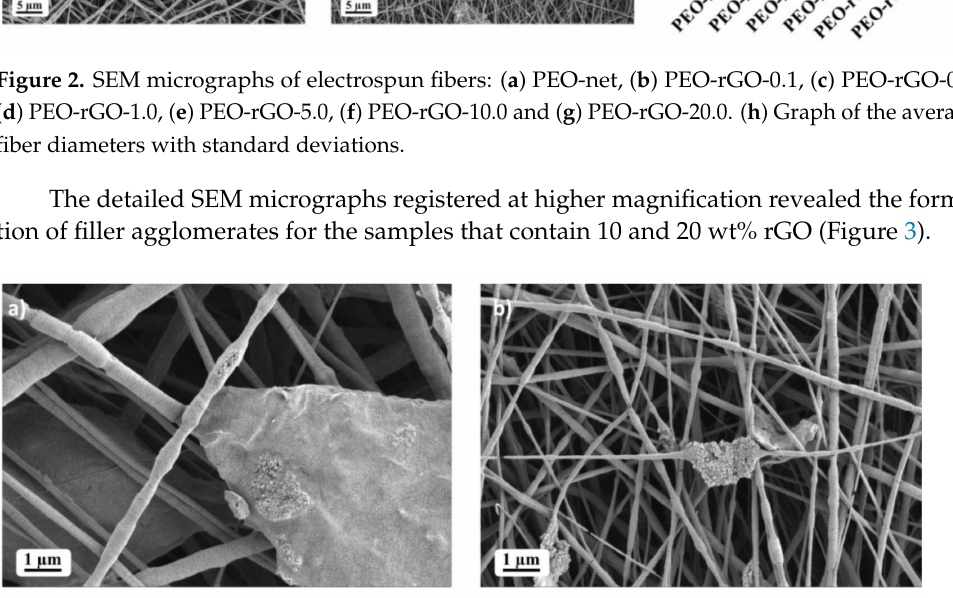
Figure 3. SEM micrographs of ( a ) PEO-rGO-10.0 and ( b )